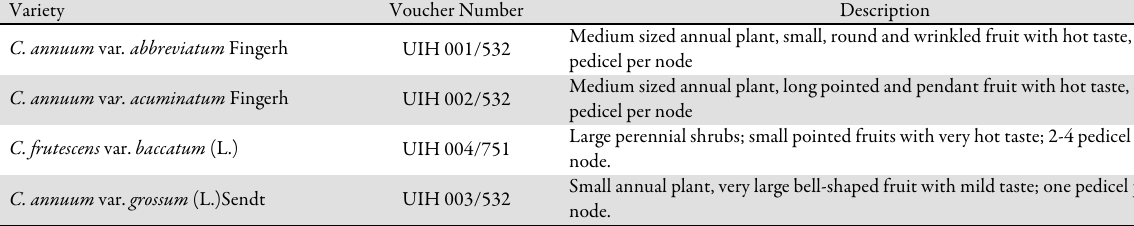
Table 1. Description of pepper plants used in this study Variety